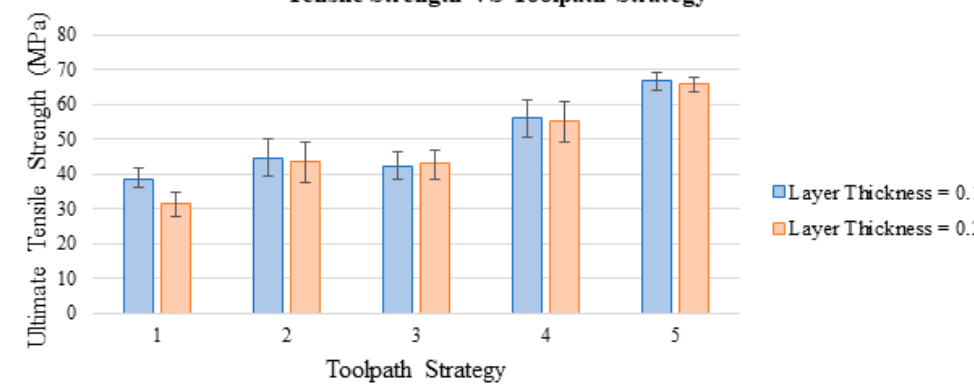
Figure 10. Tensile strength measurements based on different printing strategies. To verifying the significance level of each variable to the tensile strength, an ANOVA analysis of variance (Table 4) is conducted for “layer thickness” and “toolpath strategy” factor with “tensile strength” as the response. The “rotational angle” is not included in this study because the contour and proposed toolpath do not have any rotational angle value. From Table 4, the P-value for toolpath strategy is 0.001<0.005, which means that